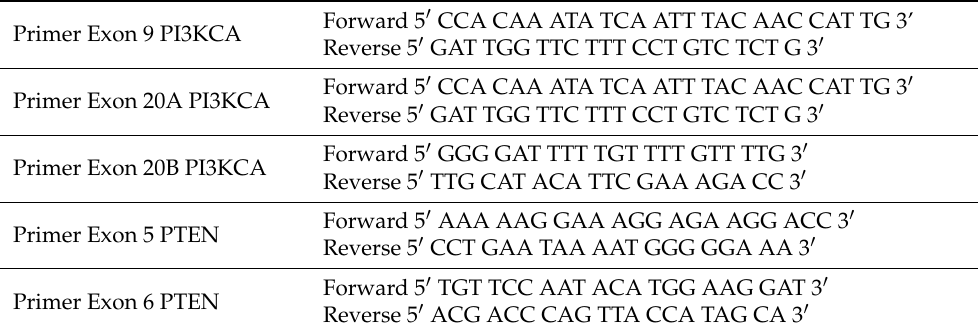
Table 1. Sequence of primers for mutational analysis of PI3K and PTEN